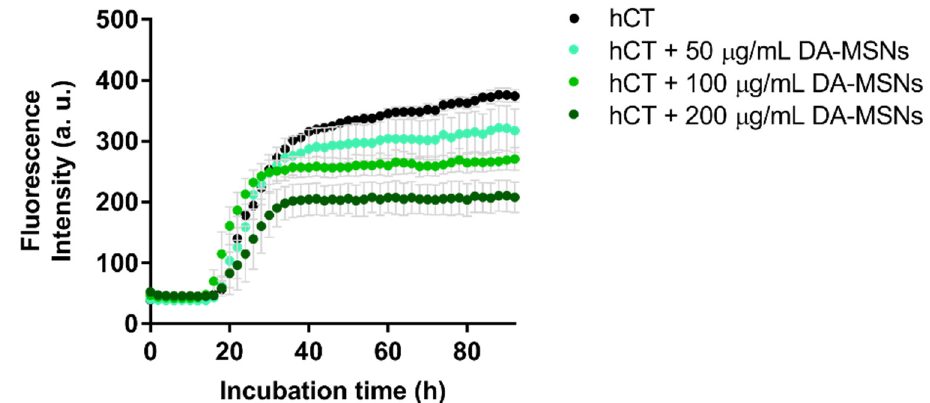
Figure 7. ThT-monitored hCT aggregation kinetic in the presence of DA-MSNs.